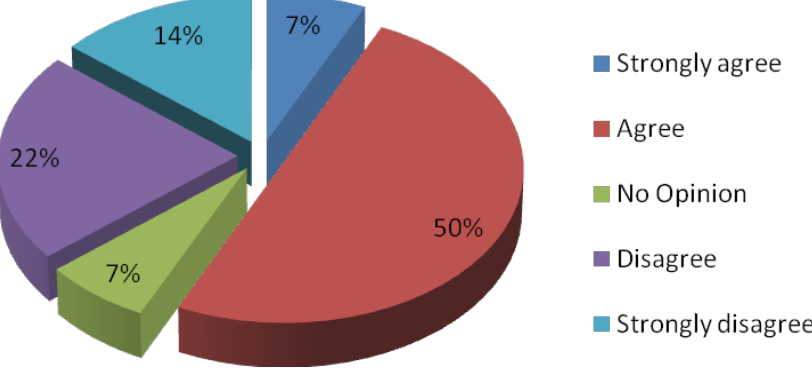
Figure 3 Advancing interoperability for BIM